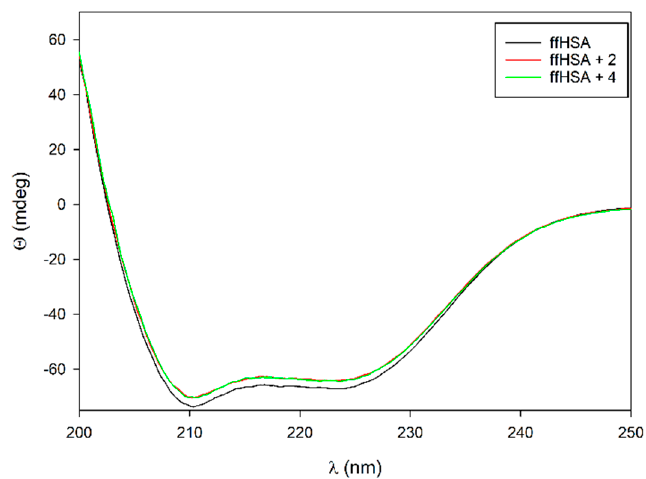
Figure 3. Circular dichroism spectra of 5 µ M ff HSA albumin (black) and upon addition of 2 (red) and 4 (green) at 100 µ M concentration.